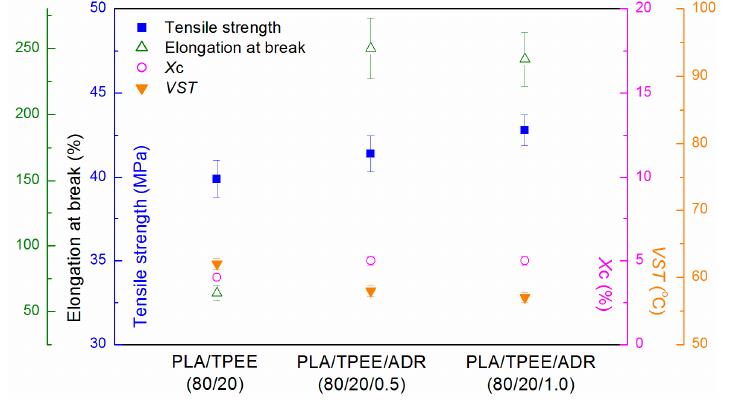
Figure 5. Data of tensile performances, X c and VST of quenched PLA/TPEE/ADR (80/20/ x ) blends.